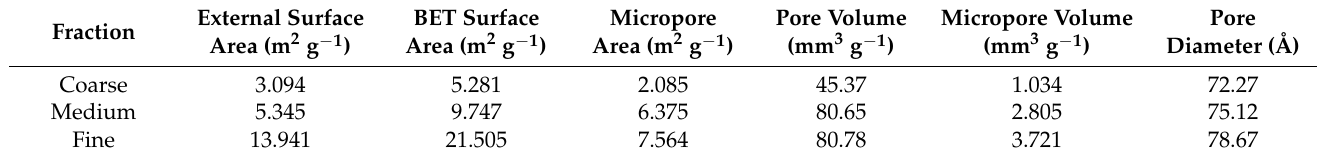
Table 2. Surface area and pore volume for calcined adsorbent